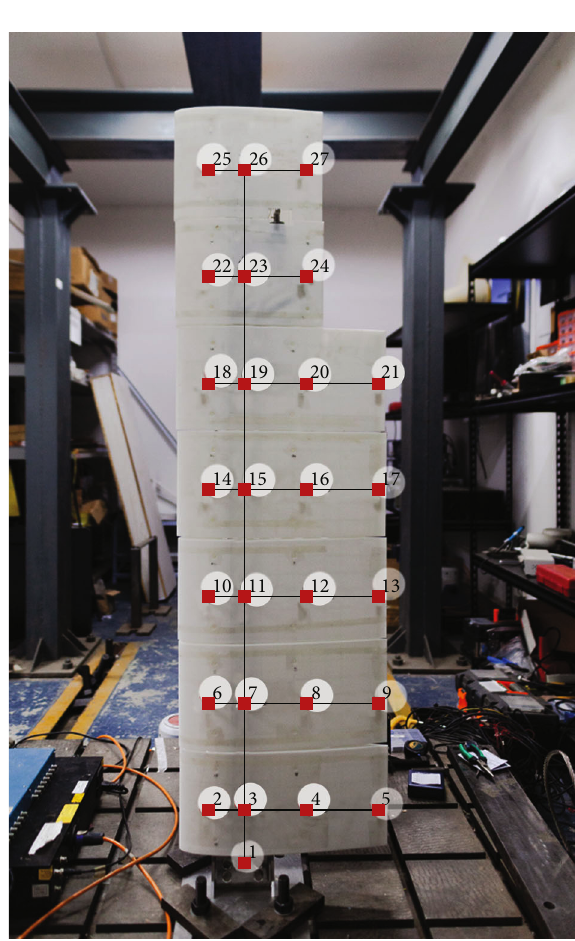
Figure 7: The test model of the main wing (Point.1 is the fi xed point and Point.2 to 27 are measured points, while the location of excitation is Point.8).